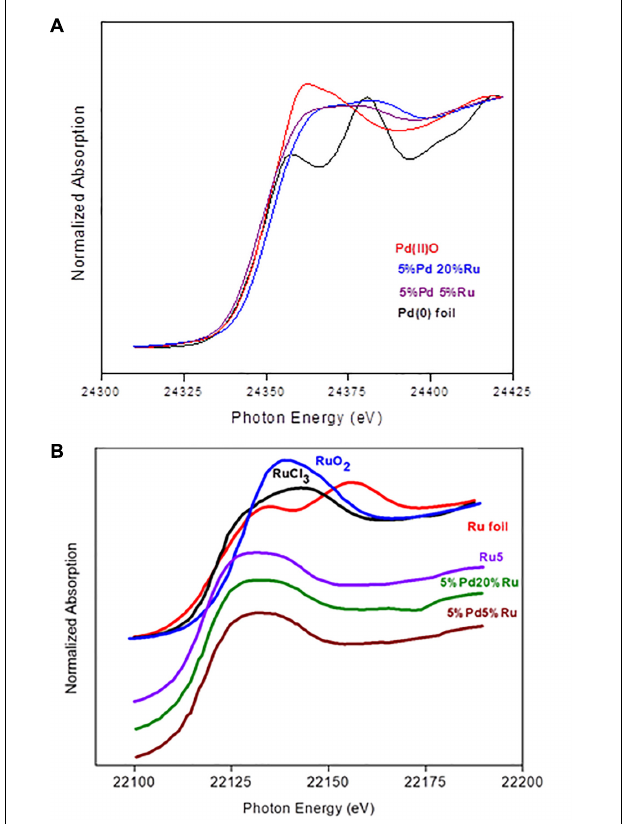
FIGURE 4 | (A) XANES region of EXAFS spectra of the Pd K-edge in reference compounds (Pd foil and PdO) and for Pd-Ru biogenic NPs samples. (B) XANES spectra of ruthenium foil, RuO 2 , RuCl 3 , 5% Ru, and for Pd-Ru biogenic NPs